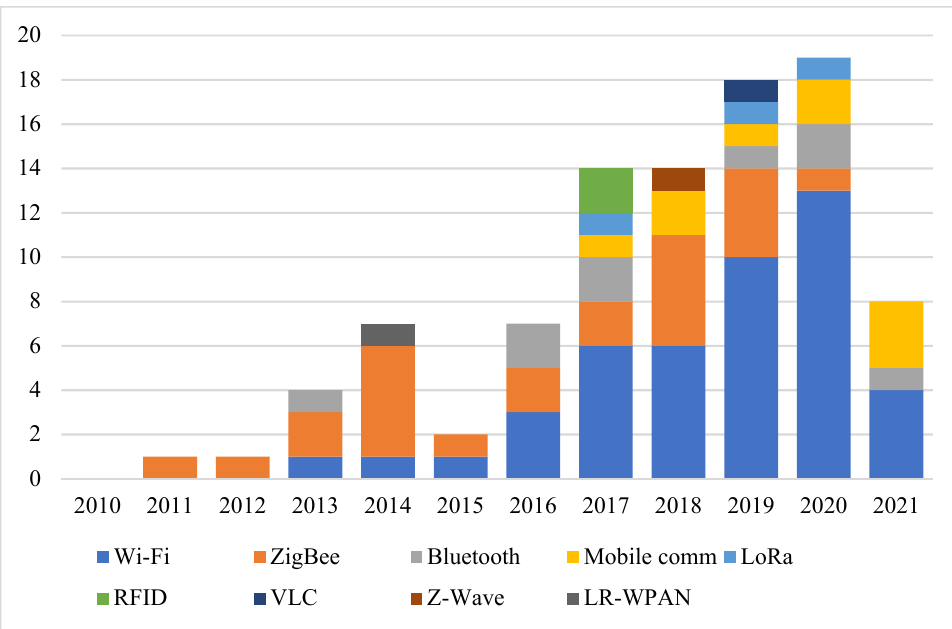
Figure 7. Percentage of types of communication technology per year.